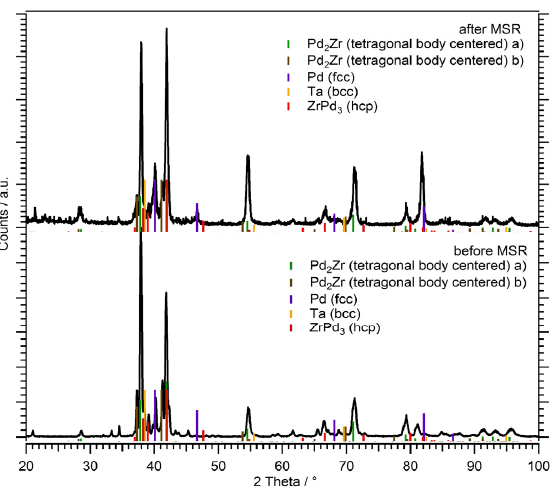
Figure 4. XRD patterns of the Pd ‐ Zr system with a nominal starting stoichiometry of Pd:Zr = 2:1 before ( lower panel ) and after ( upper panel ) methanol steam reforming up to 873 K.